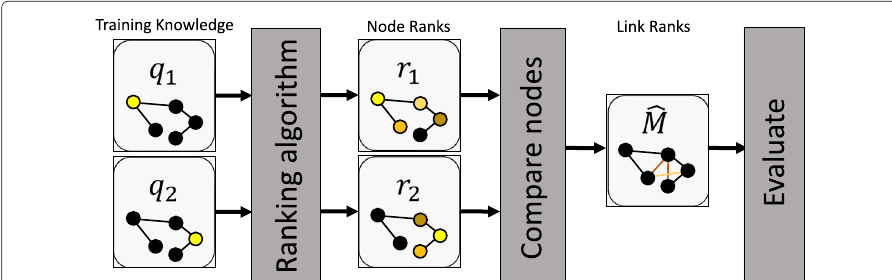
Fig. 4 Proposed scheme for evaluating ranking algorithms. Lighter colored nodes have higher ranks and are closely related to the respective metadata group. Lighter colored edges have lower link ranks are hence less likely to